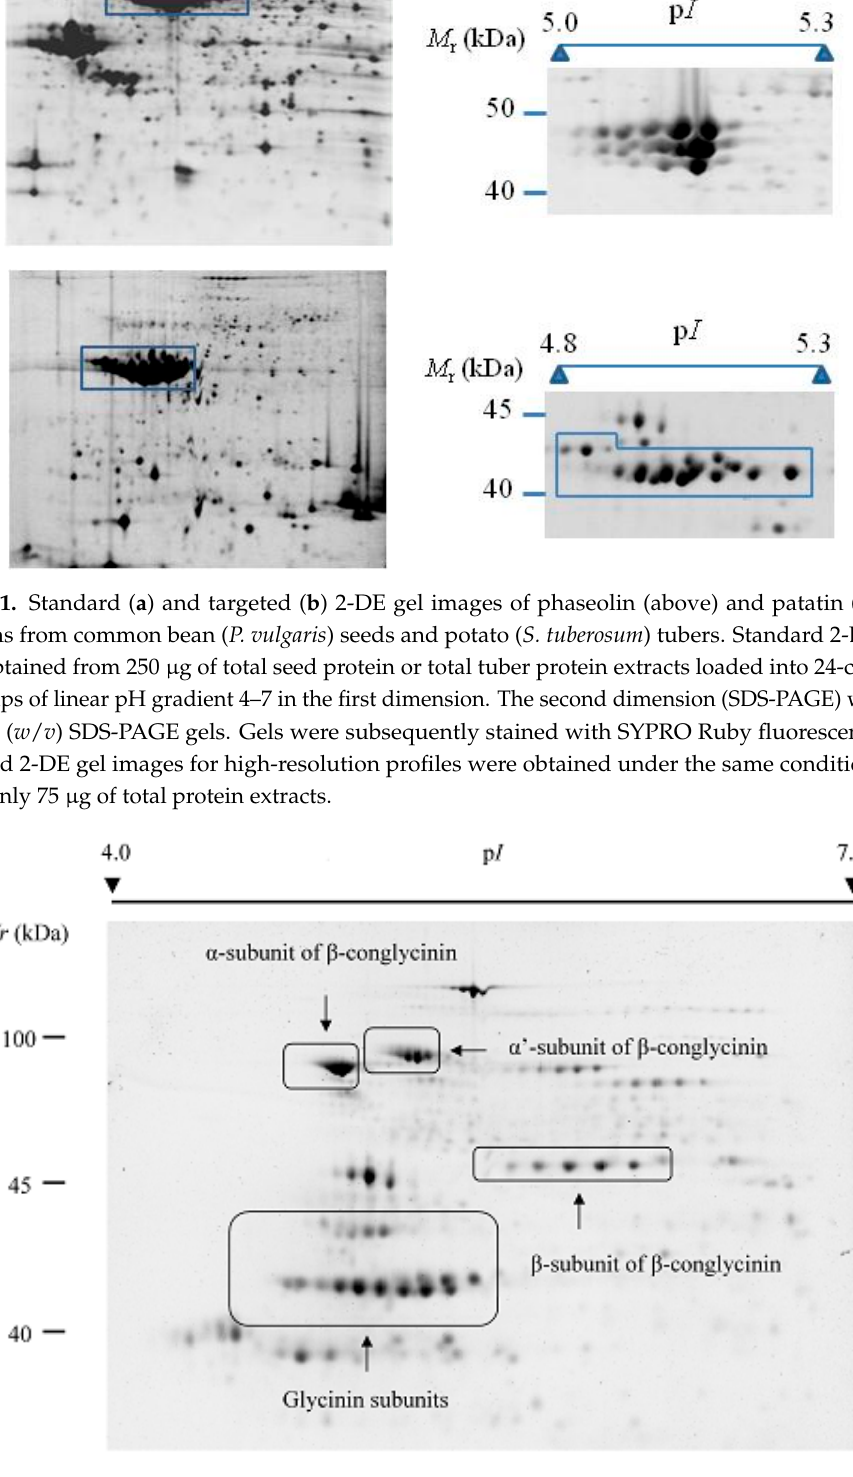
Figure 2. Gel image of high-resolution profile of soybean ( G . max ) storage proteins ( β -conglycinin and glycinin subunits) obtained by the targeted 2 ‐ DE.